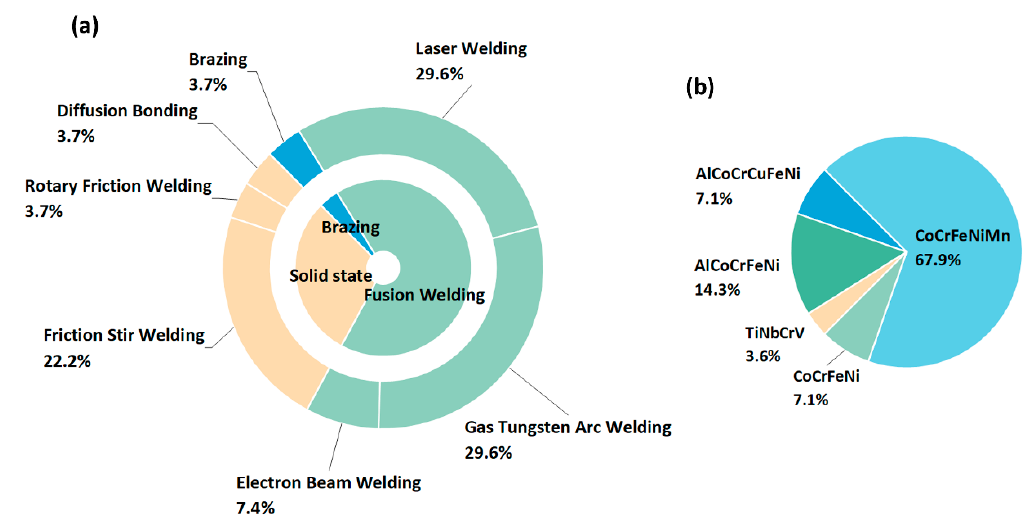
Figure 13. Percentage distribution of the number of papers considered in this study: ( a ) by welding technique; ( b ) by alloy system.